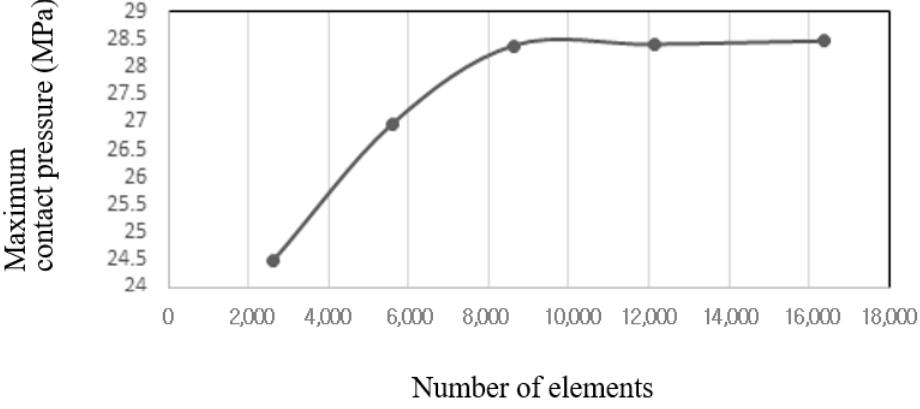
Figure 9. Mesh size convergence check graph.